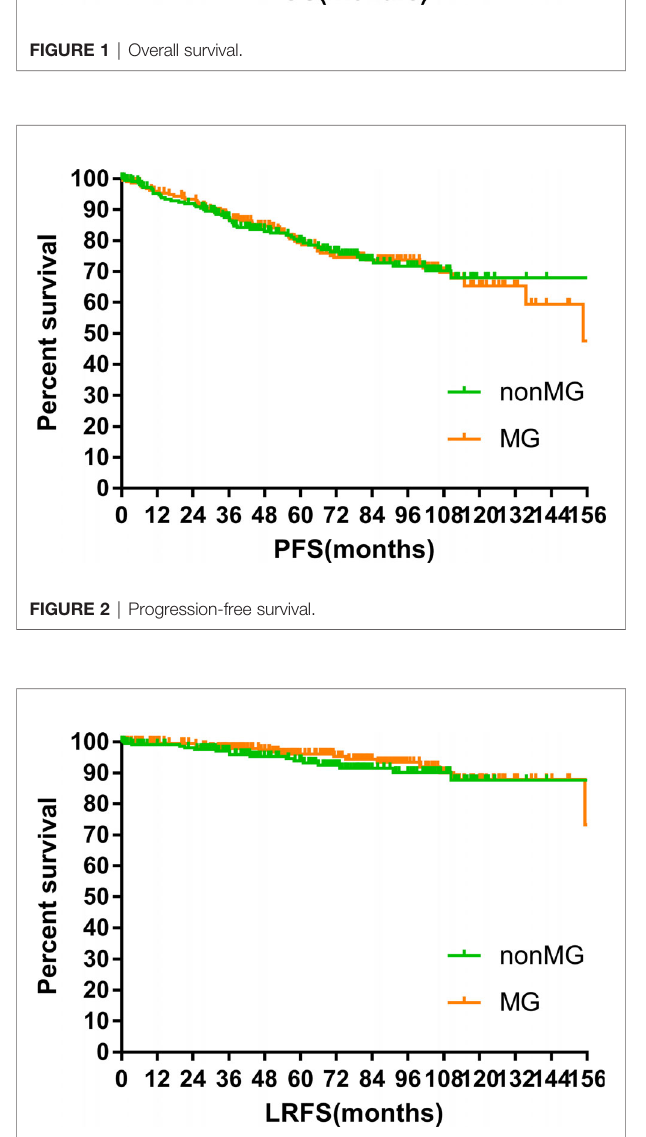
FIGURE 3 | Local-regional relapse free survival.